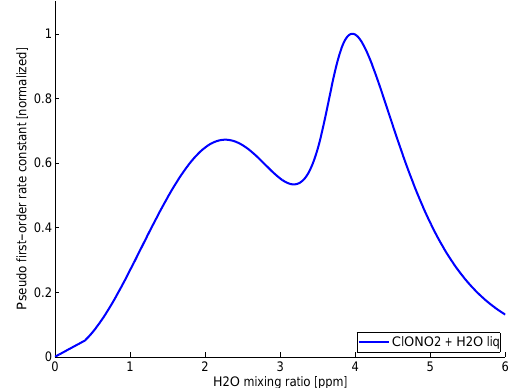
Figure 11. Normalized pseudo first-order rate coefficient of ClONO 2 loss as a function of H 2 O mixing ratio for the hetero- geneous reaction ClONO 2 + H 2 O on liquid STS surfaces. Reac- tion rates were calculated for T = 190K, p = 50hPa, 10ppb HNO 3 , 0.15ppb H 2 SO 4 , 2ppb HCl and 1ppb ClONO 2